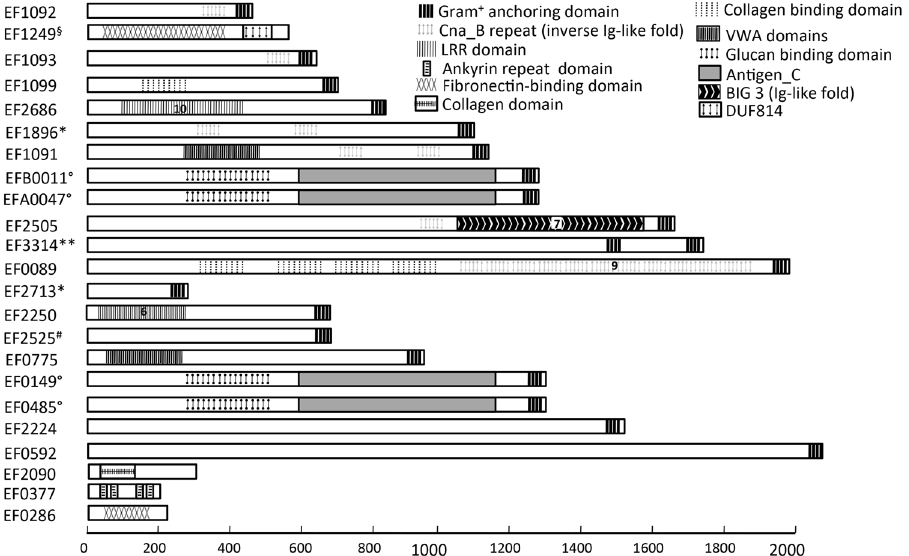
Figure 1. Representation of the E. faecalis set of proteins with their domains. The proteins are designed by their EF numbers; some of them were also published with the following names: EF1092: EbpB, EF1093: EbpC, EF1099: Ace, EF2686: ElrA, EF0775: EbsG, EF1896: Fss3, EF1091: EbpA, EFB0011: PrgB, EFA0047: Asa1, EF0149: PrgB-like, EF0485: AS, EF0089: Fss1, EF1249: EfbA. Additional information on expression or homology of the protein are shown as follows: * enriched in clinical isolates; ** induced in the gastrointestinal tract; °aggregation substance-like; # phage-like protein; § FbpA like